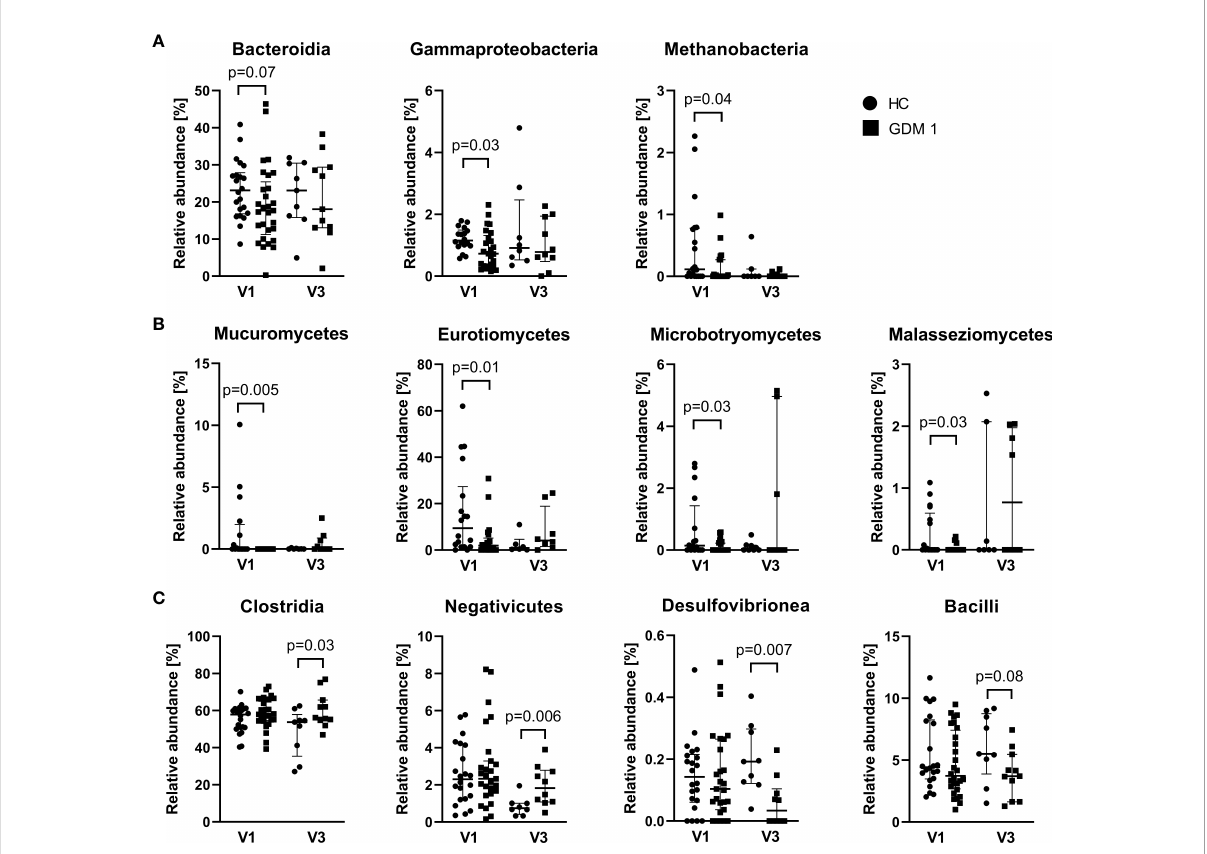
FIGURE 3 Differently abundant classes of bacteria and fungi between normoglycemic women (HC) and women with early-diagnosed GDM (GDM 1) at the fi rst trimester – V1 (A, B) and the bacterial classes in the third trimester – V3 (C) . Only signi fi cantly different classes are shown. The data are presented as medians with interquartile range. The abundances were compared by Mann-Whitney U test and p < 0.05 was considered statistically signi fi